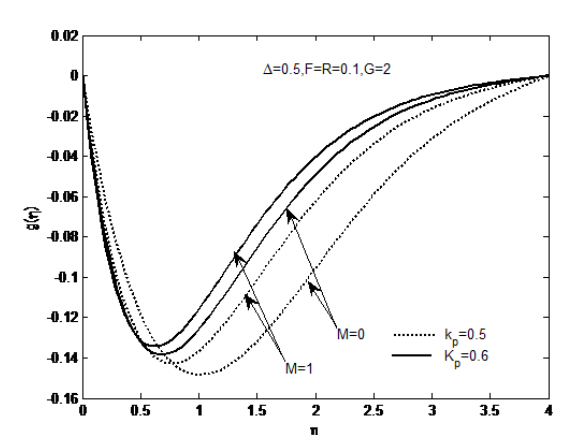
Fig. 6: Angular velocity profile for different values of M and K p